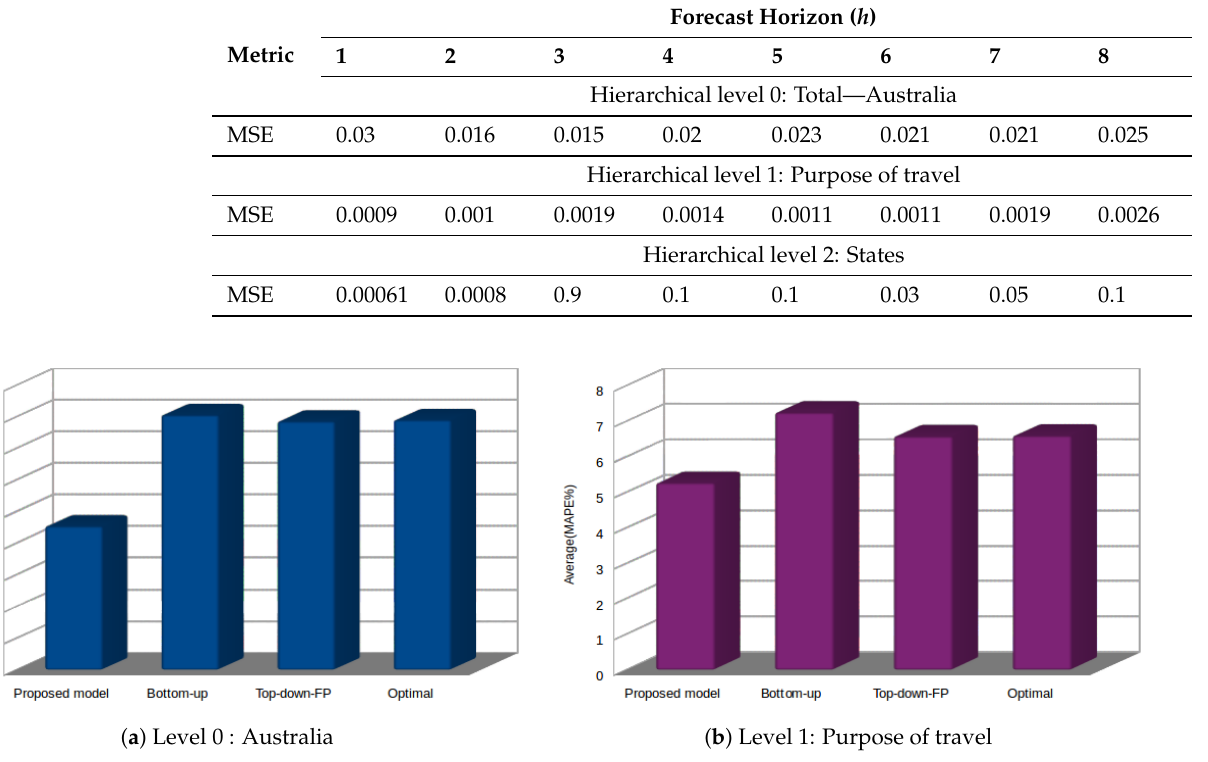
Table 8. Hierarchical forecasting for Australian tourism visitor nights: Coherence performance metric.